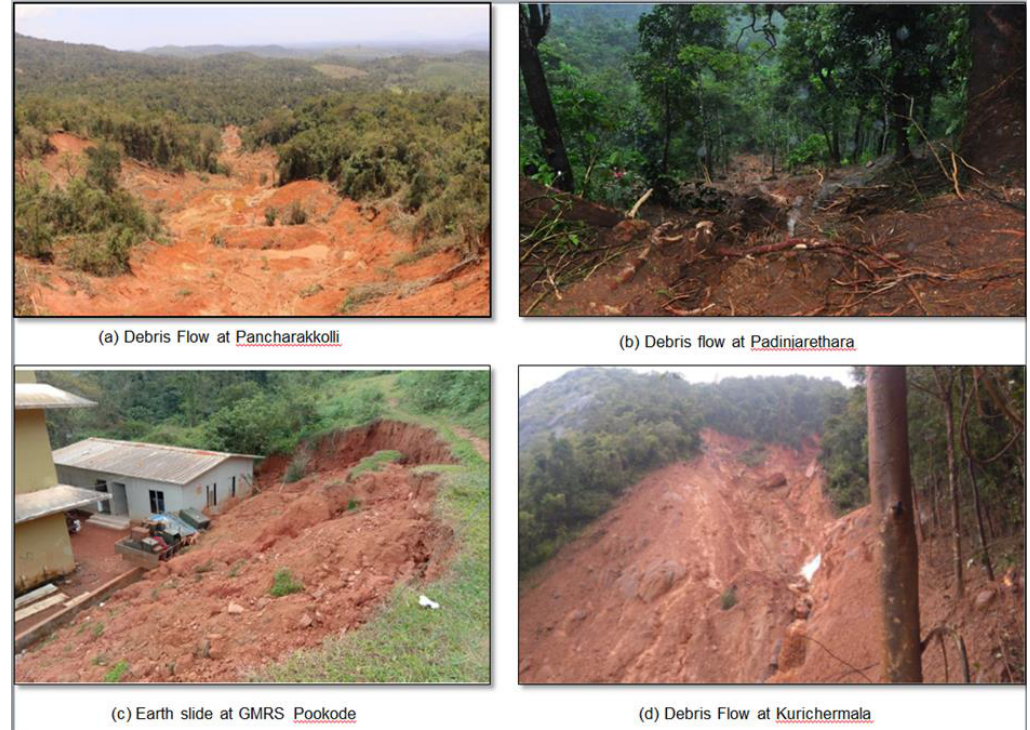
Figure 2. Images of landslides that occurred in Wayanad district during the 2018 monsoon.